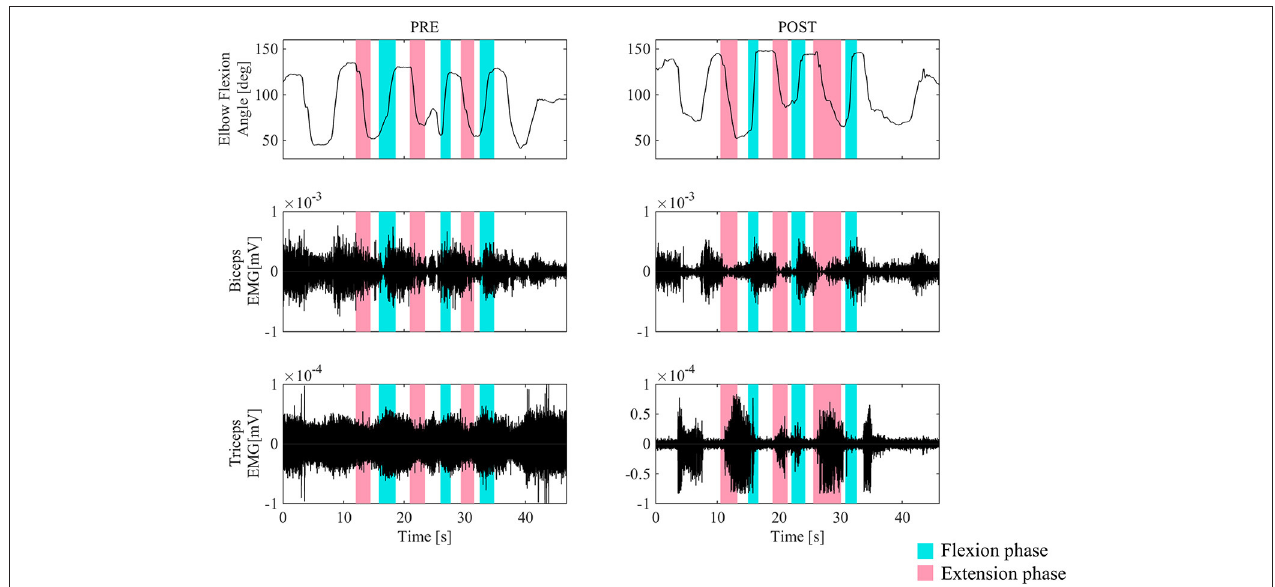
FIGURE 3 | The surface EMG of the biceps and triceps brachii during elbow flexion (blue) and extension (red) for the right arm before and after the second HAL session for the right elbow in Case 1. Before the session, a coactivation of the biceps and triceps was observed in the elbow extension phase. After the session, the triceps muscle was activated in the extension phase dominantly. Periodic activation of these muscles was